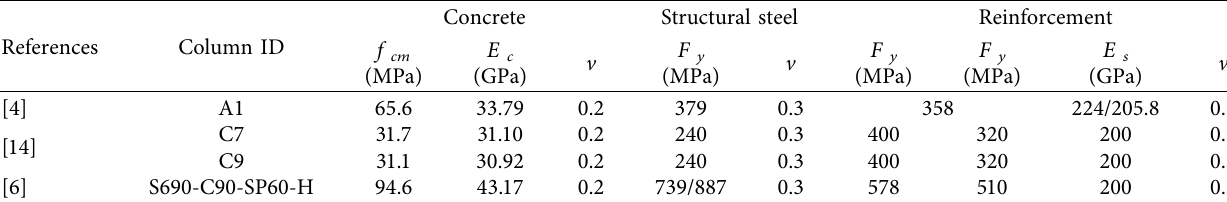
Table 9: Material properties of selected FEC test columns for validation.